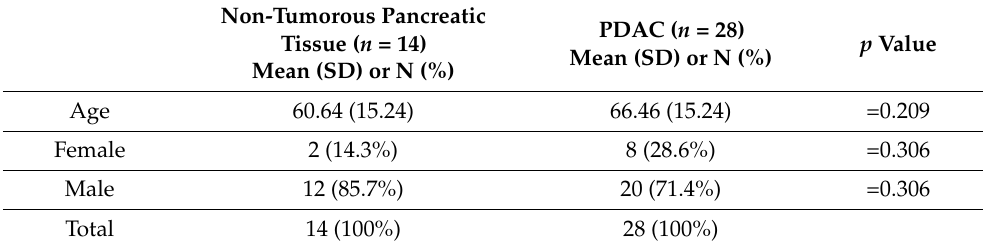
Table 1. The distribution between gender of PDAC and control group.